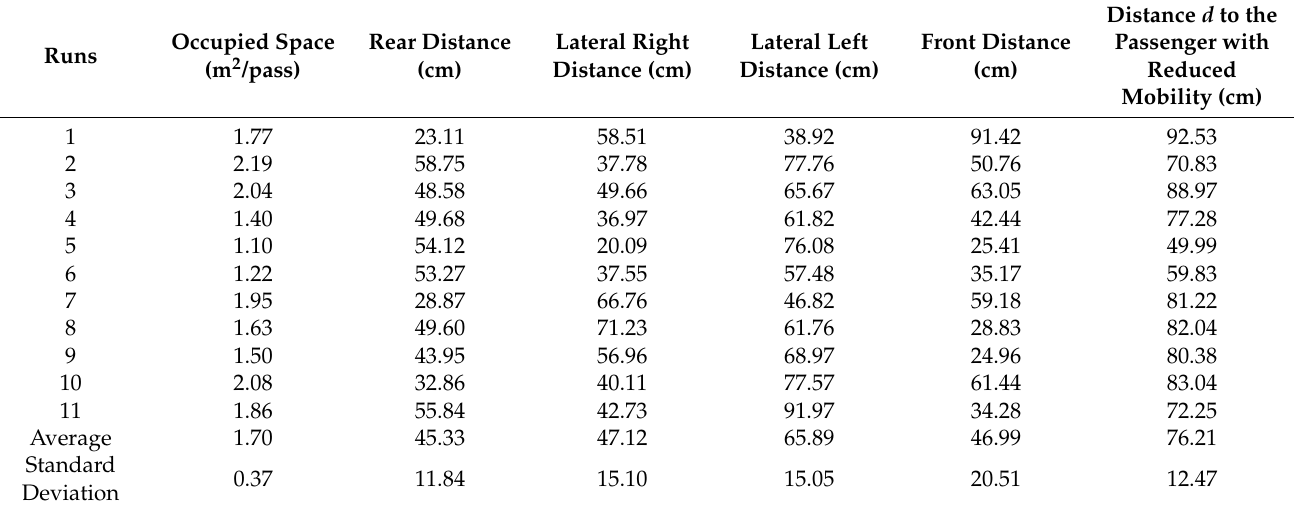
Table 2. Average space occupied by a passenger using a pram waiting to board the